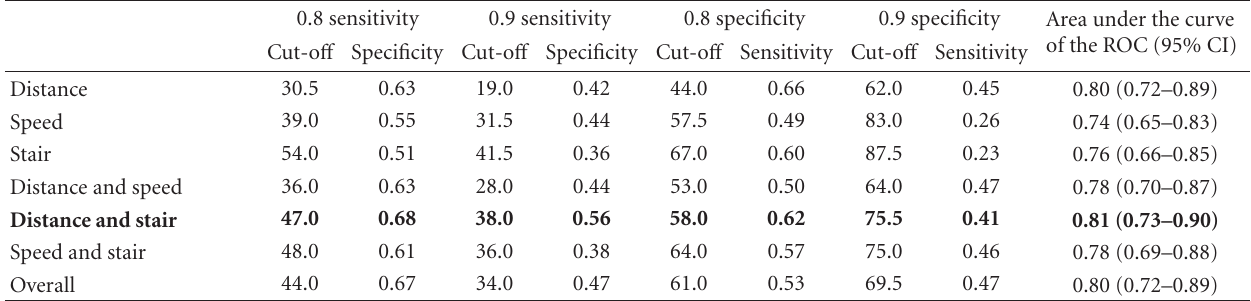
Table 5: Cut-o ff s for the WIQ subscores and combined scores for various sensitivities and specificities as well as the area under the curve of the ROC for identifying those in the high walking ability